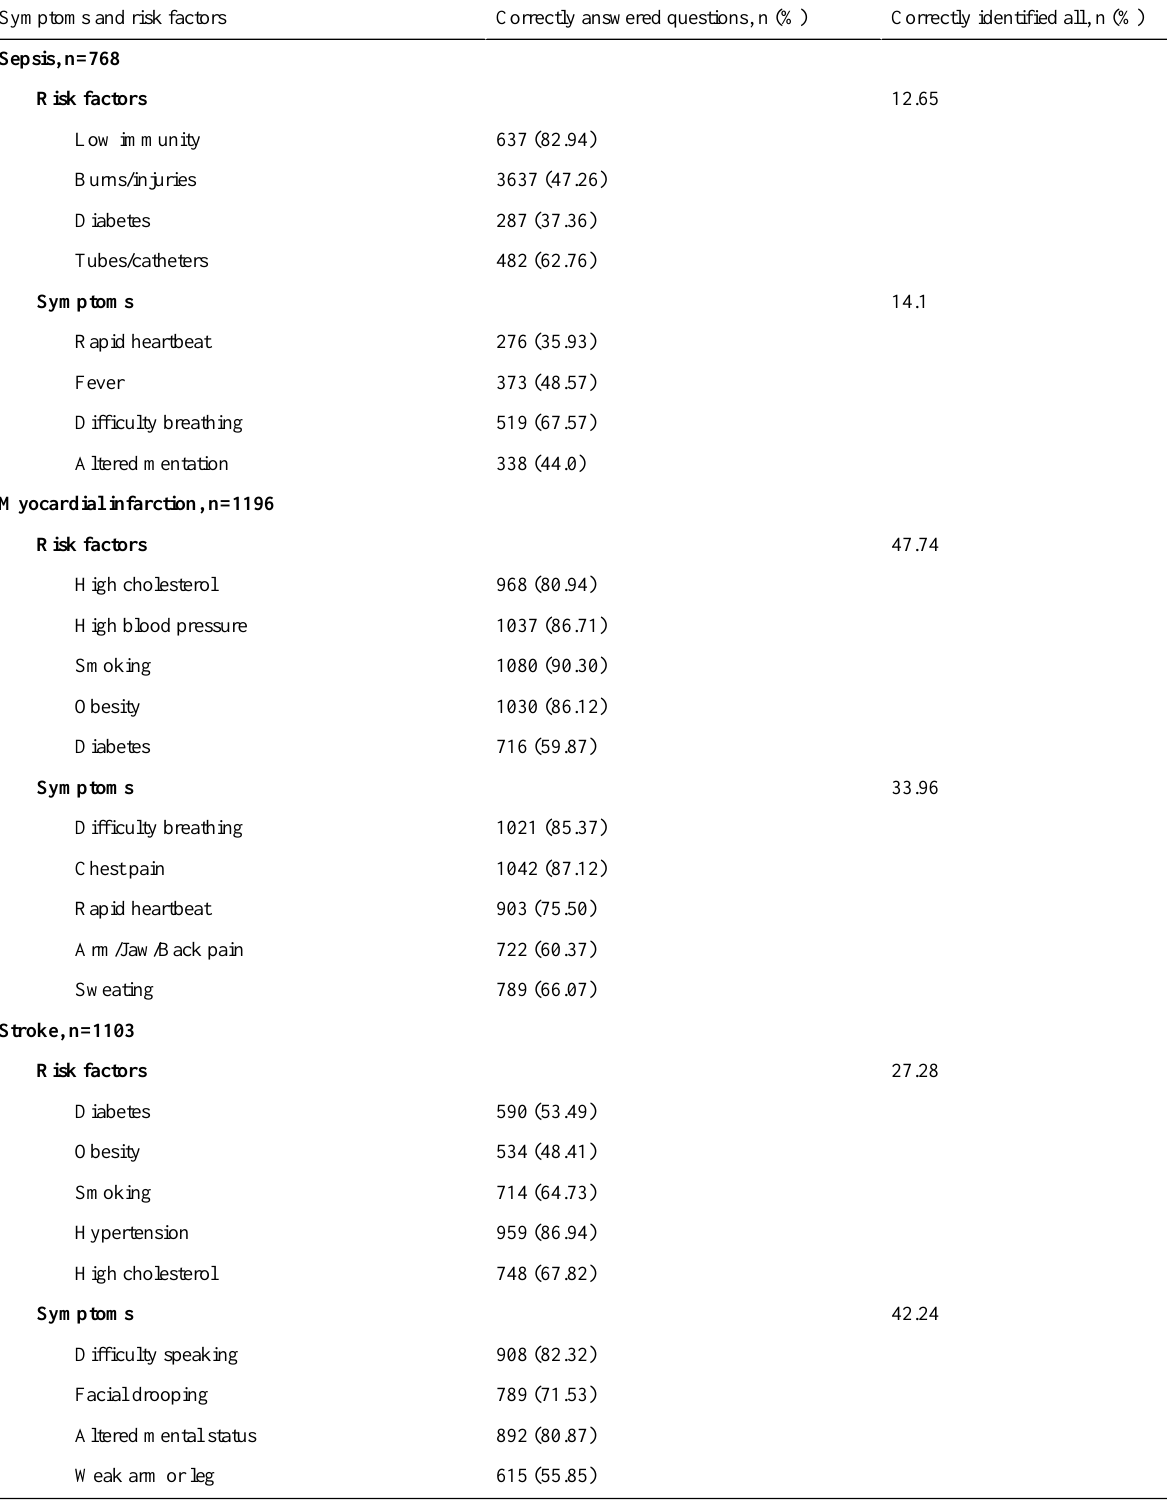
Table 3. Participant knowledge of sepsis, myocardial infarction, and stroke risk factors and